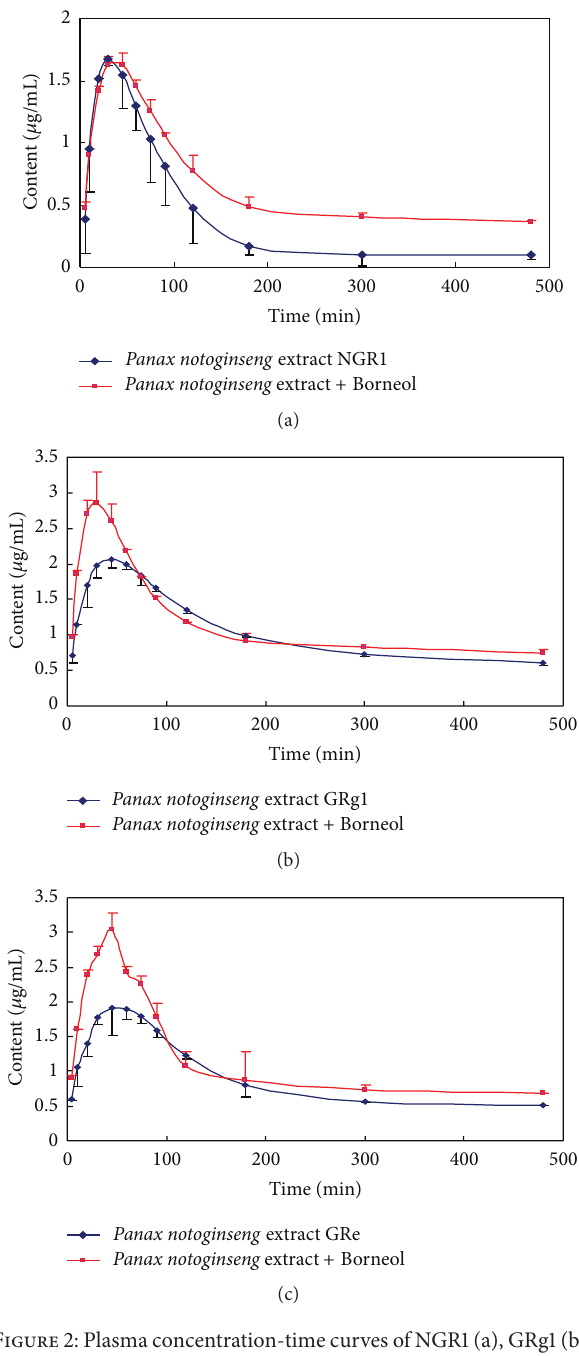
Figure 2: Plasma concentration-time curves of NGR1 (a), GRg1 (b), and GRe (c) after administration of Panax notoginseng and Panax notoginseng combined with Borneol extracts in rabbit, respectively.